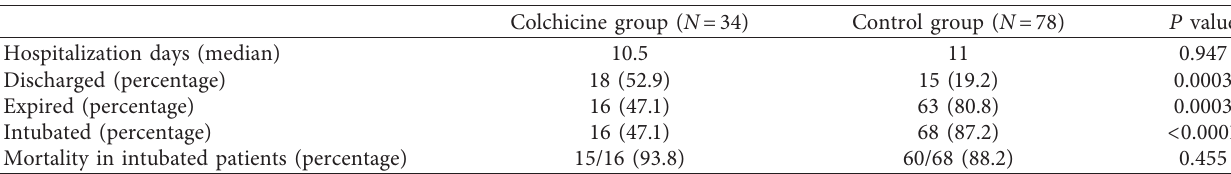
Table 5: Survival or need for mechanical ventilation in comprehensive analysis colchicine and control groups. Hospitalization days were nonnormally distributed. The Mann–Whitney U test was used to check for differences in the two groups. The χ 2 test was used to check for differences in the number of intubations, patients expired, and patients intubated in the two groups and mortality in intubated